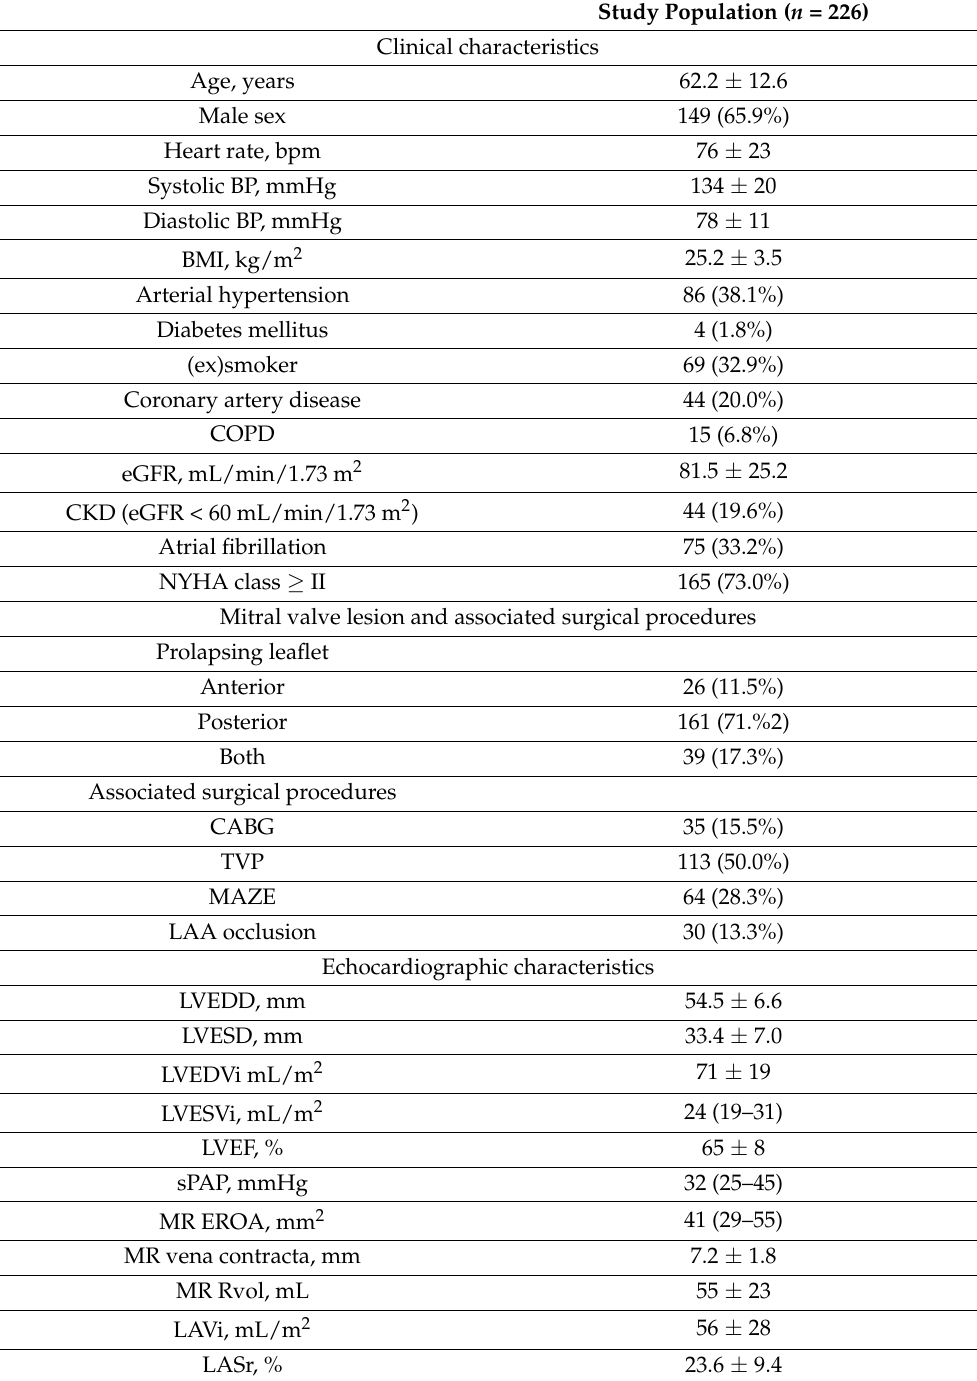
Table 1. Baseline clinical and echocardiographic characteristics of the total study